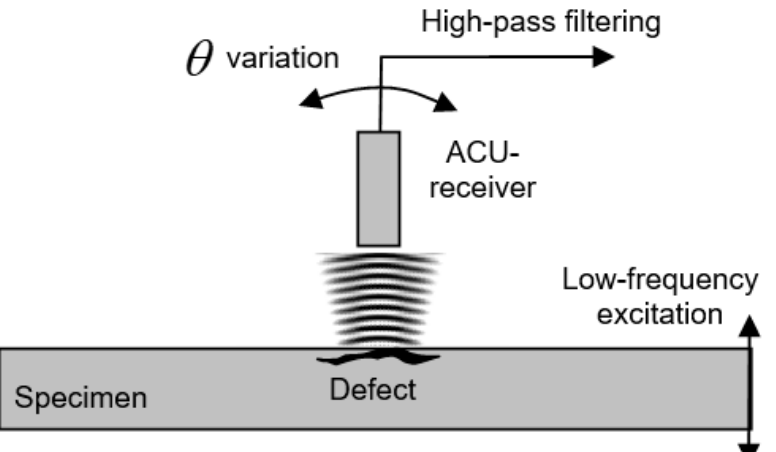
Figure 9. Setup for detecting nonlinear AE and applying it to imaging of defects.